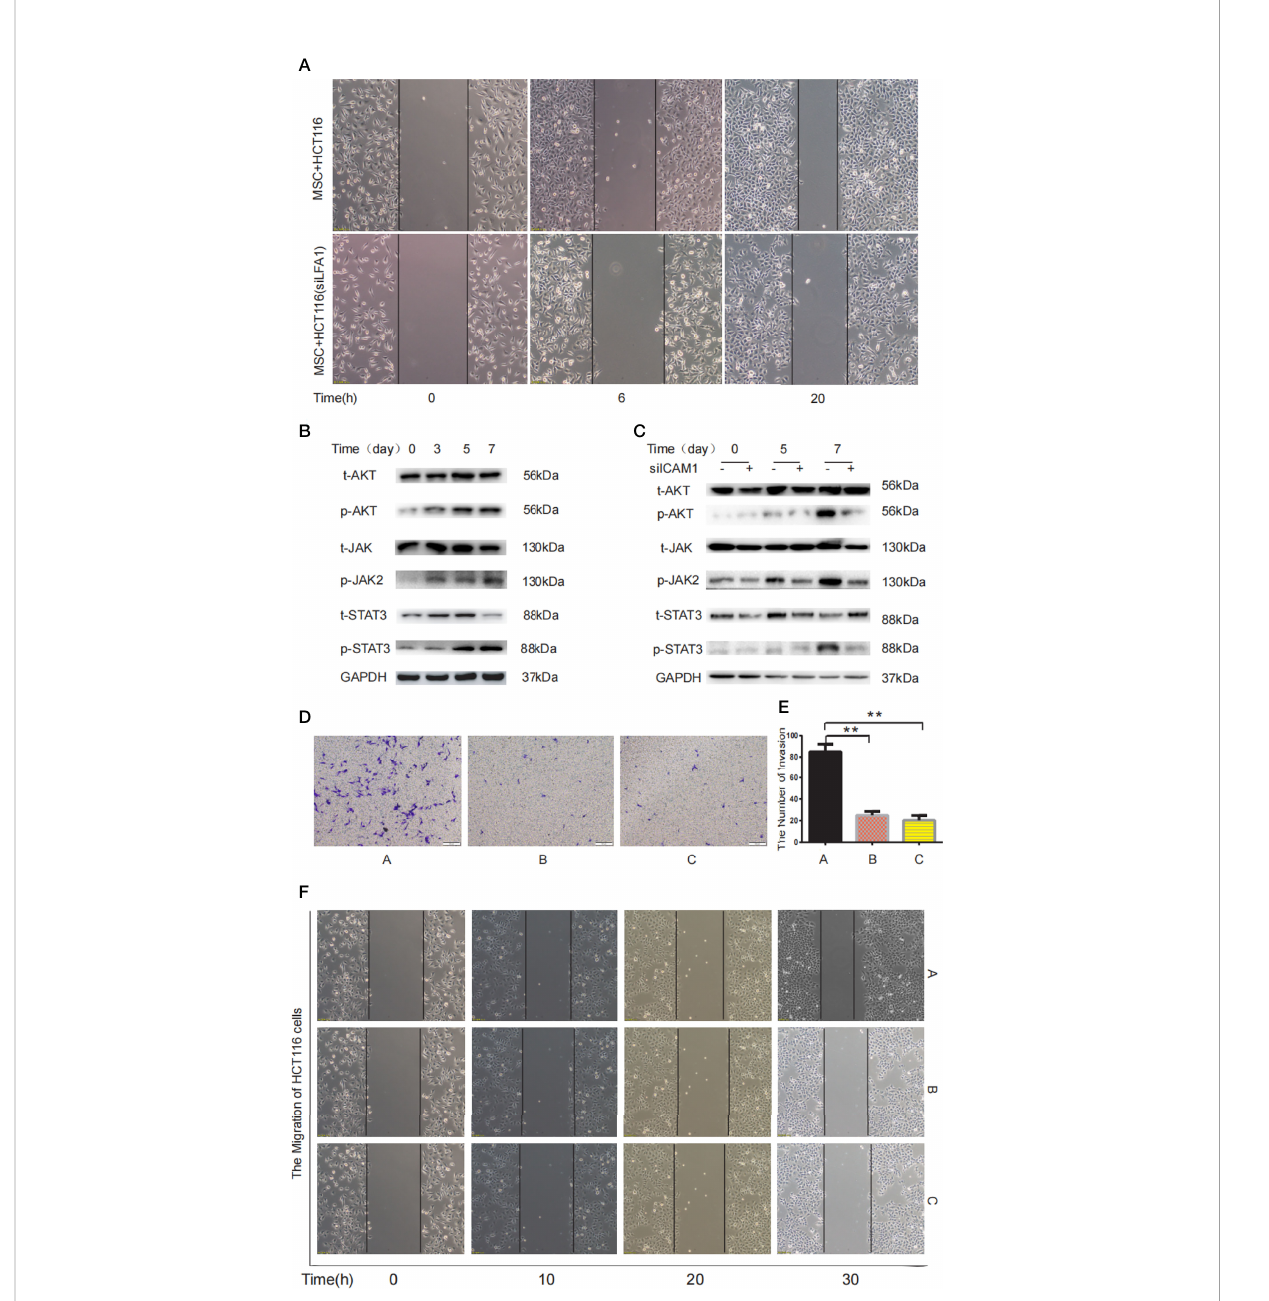
FIGURE 6 MTCAF-derived ICAM-1 mediates STAT3 and Akt signaling pathways in colon cancer cells. (A) The migration ability of HCT116 cells was detected by wound healing in two different treatment groups including MSC co-culturing with HCT116 cells or HCT116 cells with LFA inhibitor (44 nM) groups. (B) Western blotting assay was used to detect the phosphorylation of AKT and STAT3 in HCT116 cells when HCT116 cells and MSCs were co-cultured at days 0, 3, 5, and 7. GAPDH was used as the control group. (C) Western blotting was used to detect AKT and STAT3 signaling pathway in HCT116 cells with co-culturing with MSCs or MSCs knocking down ICAM-1. GAPDH was used as the control group. (D) Invasive ability of HCT116 cells was measured using the Transwell assay. The left shows the microscopic image of the crystal violet staining [group A represents the HCT116 and MSC co-culture group, group B represents the HCT116 and MSC co-culture group with AKT inhibitor (10 m M) group, and group C represents the HCT116 and MSC co-culture group with STAT3 inhibitor (2.14 m M) group). (E) The microscopic image of the crystal violet staining. (F) The wound healing was used to detect migration ability of HCT116 cells at different time (group A represents the HCT116 and MSC co-culture group, group B represents the HCT116 and MSC co-culture group with AKT inhibitor group, and group C represents the HCT116 and MSC co-culture group with STAT3 inhibitor group). **p<0.01 and